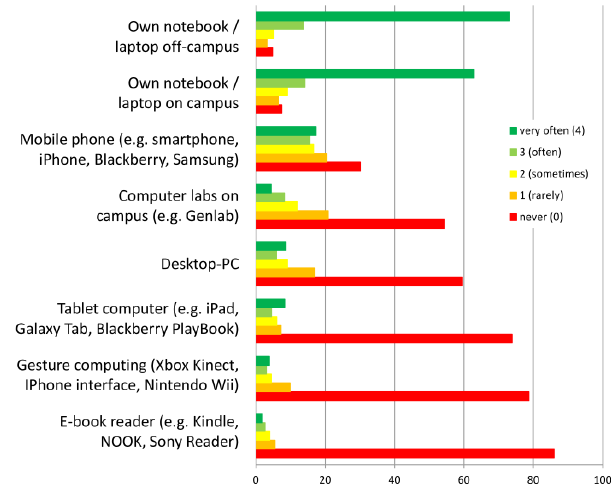
Figure 5. Valid percentage of students’ responses to